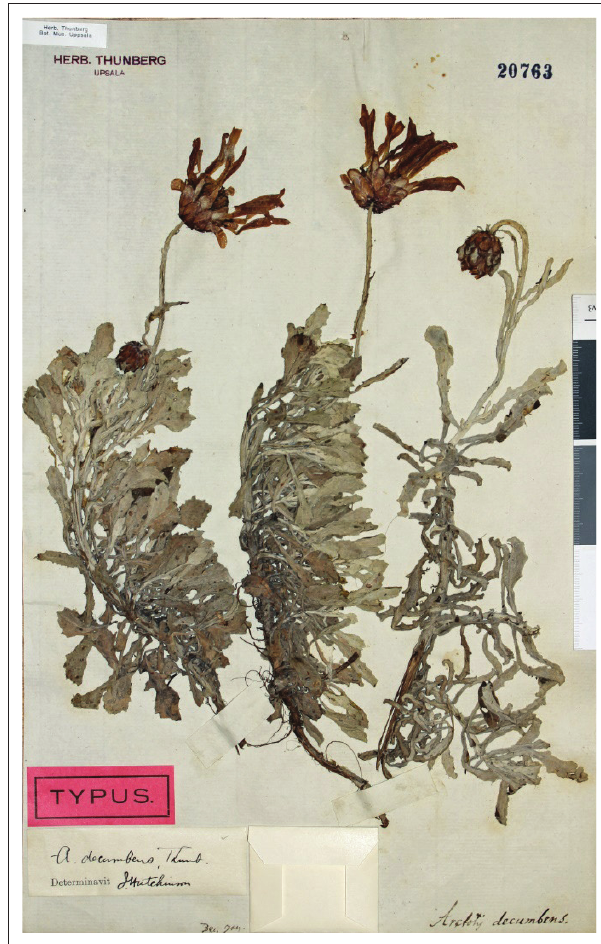
FIGURE 3: Lectotype of Arctotis stoechadifolia P.J.Bergius (SBT10247).